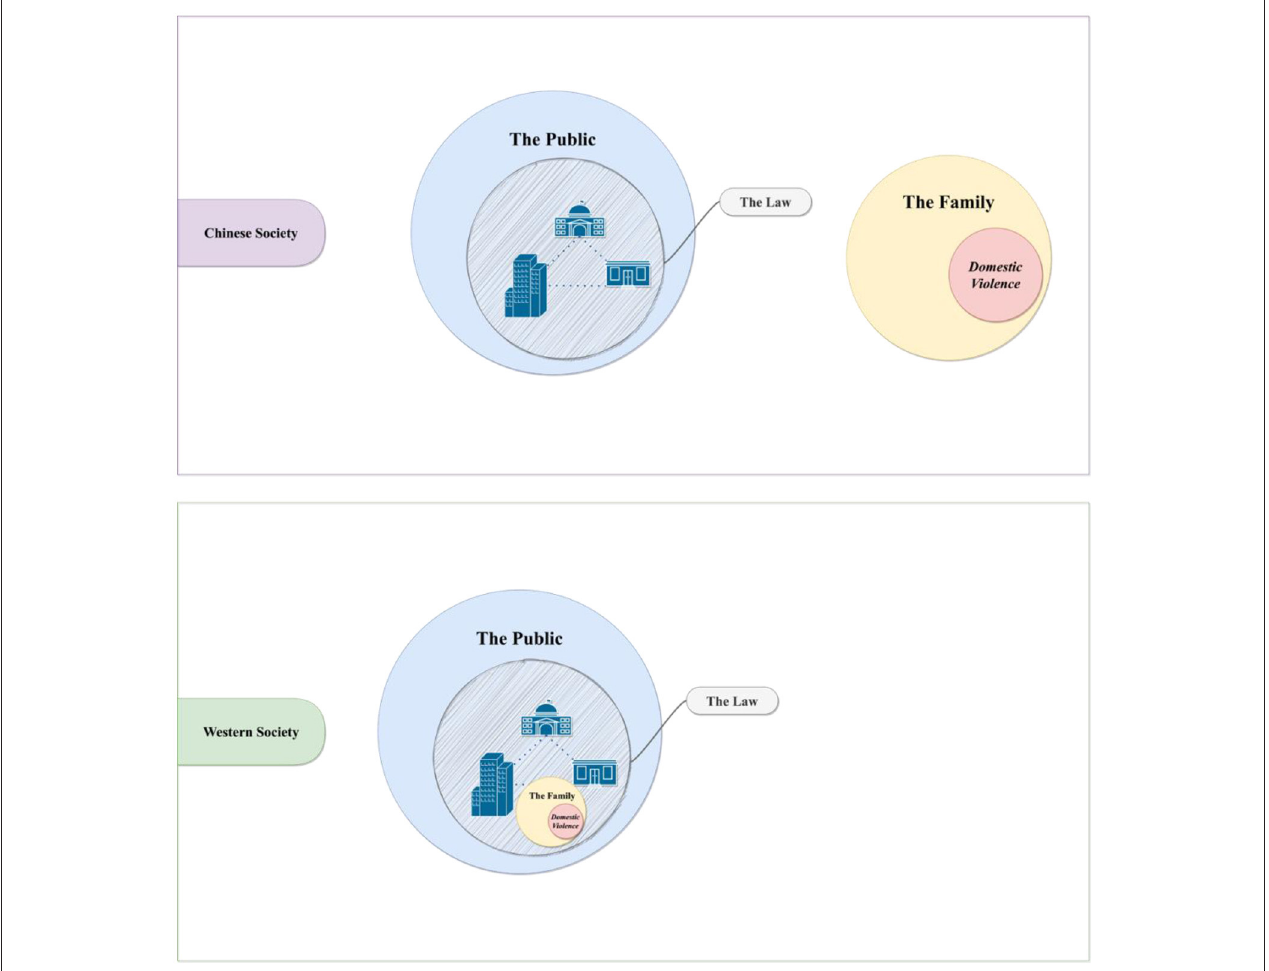
FIGURE 2 | A schematic representation of the unique categorization of domestic violence in